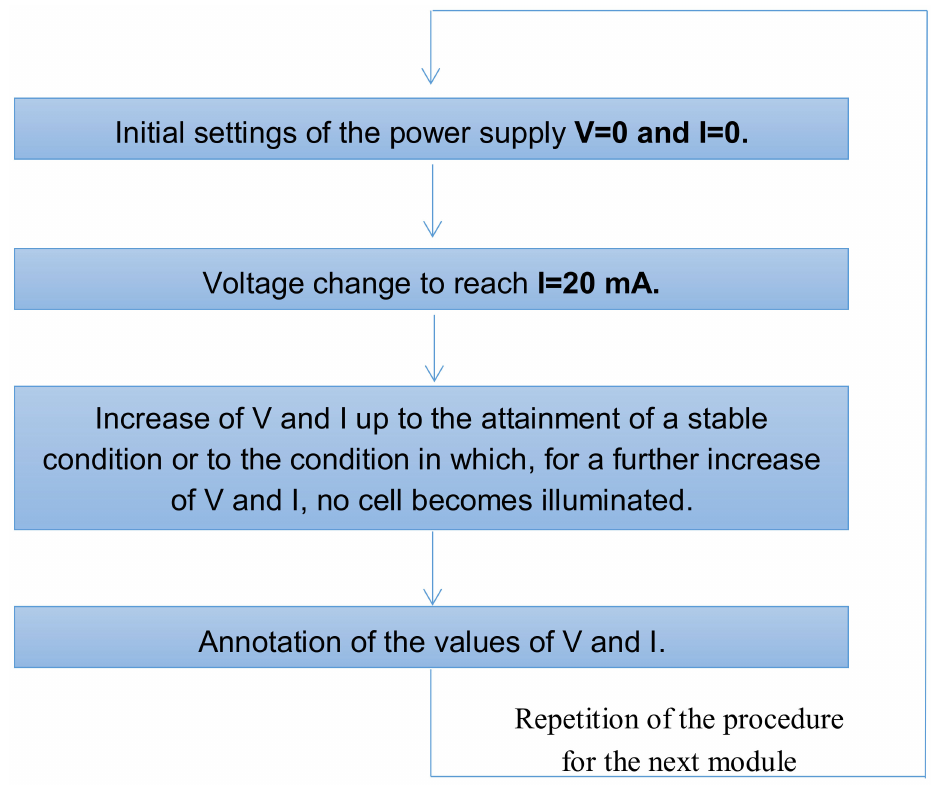
Figure 5. Methodology to choose the voltage and current values for the cells power